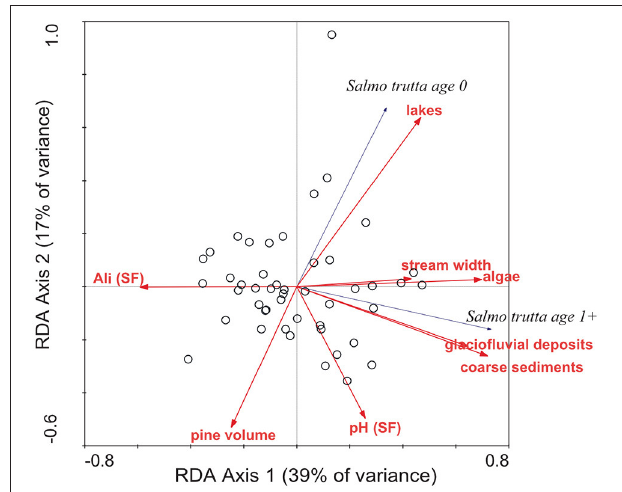
FIGURE 4 | Results of RDA multivariate analysis relating the densities of age-0 and age-1 + brown trout at 47 stream sites to selected significant environmental predictor variables. See Table 5 and Methods text for variable descriptions.